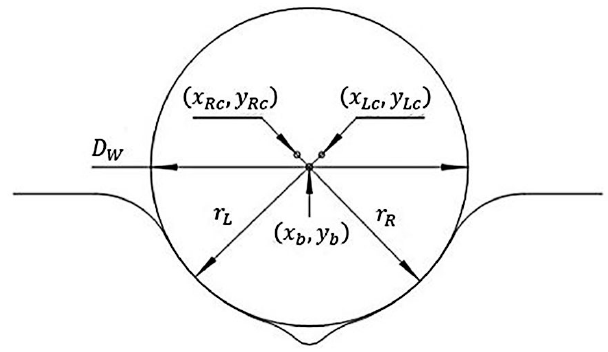
Figure 6. There are two locations for the starting point: (a) the starting point is located below the separation line; (b) the starting point is located above the separation